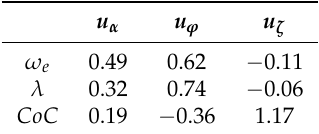
Table 1. Relative gain array (RGA) matrix of the system shown in Figure